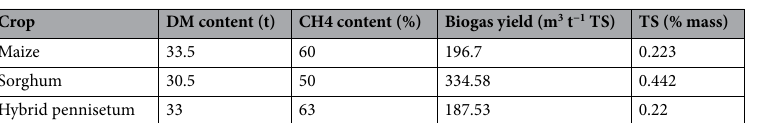
Table 1. Summary of crop characteristics. DM: dry materials, the measured weight of materials, removal of free water, is kept constant after drying. TS: total solid, organic and inorganic matters embodied in the materials. VS: volatile solid, organic matters embodied in the raw